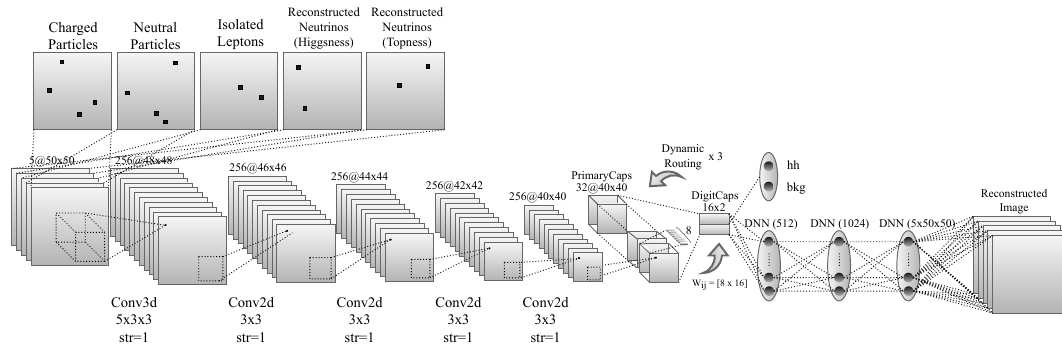
Figure 7 . A schematic architecture of the capsule network model (CapsNet) used in this paper.